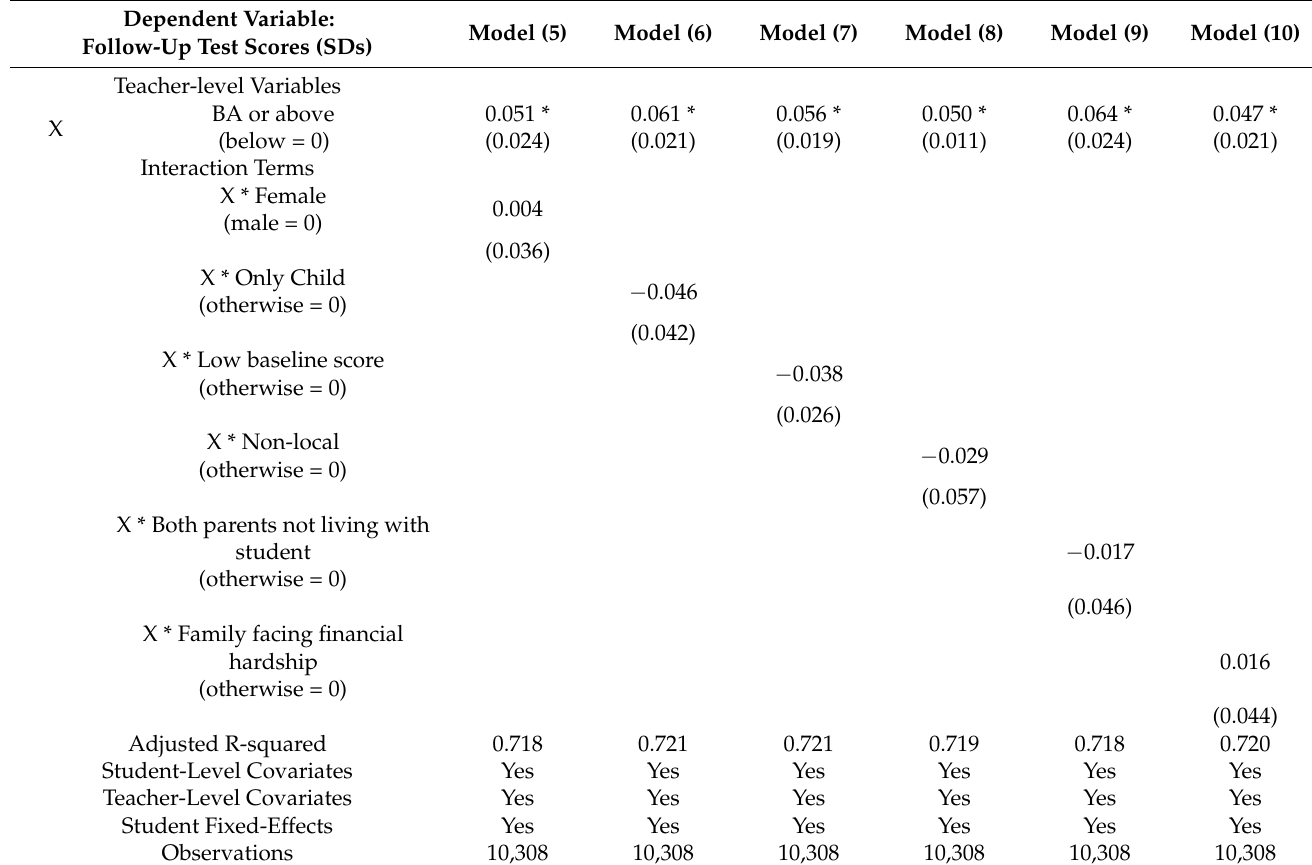
Table 8. Heterogeneous impact of educational attainment on student learning